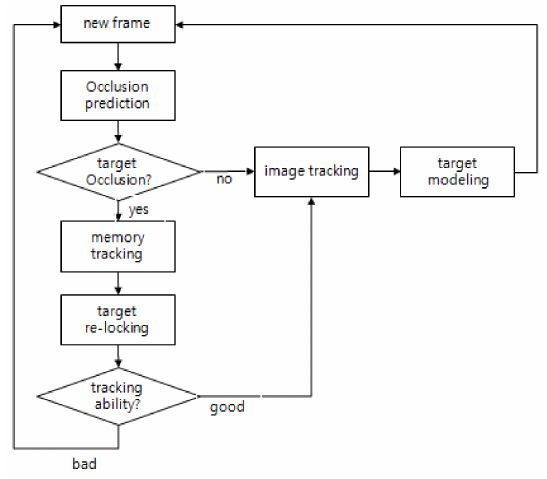
Figure 3. Flowchart of the coast mode tracking.